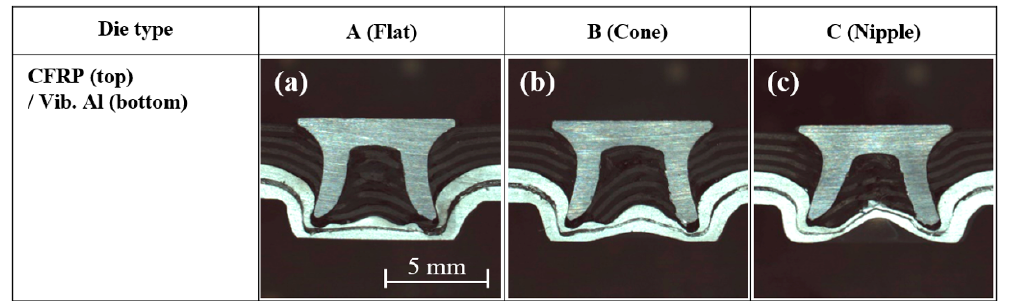
Figure 12. Cross-sectional images of a self-piercing riveted joint formed between vibration-damping Al and CFRP with respect to the die types: ( a ) die type A , ( b ) die type B , and ( c ) die type C .